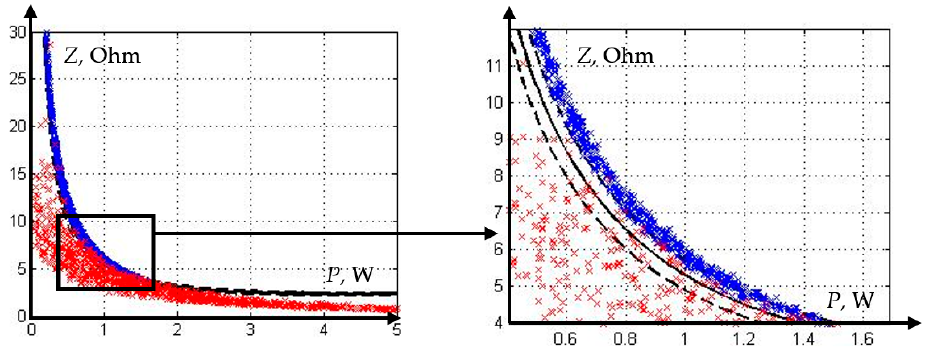
Figure 12. Location of training sample points in feature space ( P-Z ).